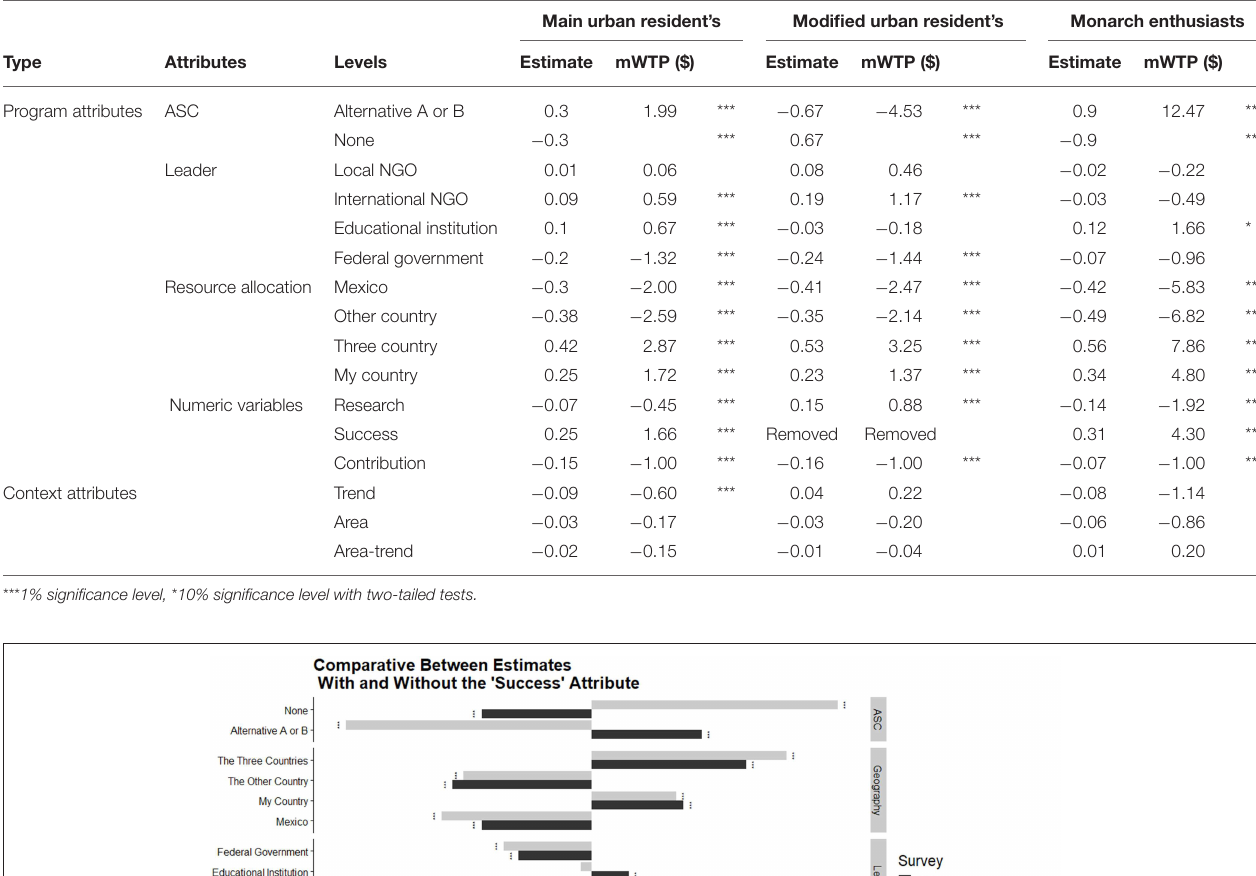
TABLE 9 | Estimates and marginal Willingness to Pay (mWTP) for the Multinomial (MNL) choice models obtained from the main urban resident’s sample with the attribute “Success” included ( n = 1,859), the modified urban resident’s sample with “Success” attribute removed ( n = 659), and the monarch enthusiasts’ samples ( n = 331).